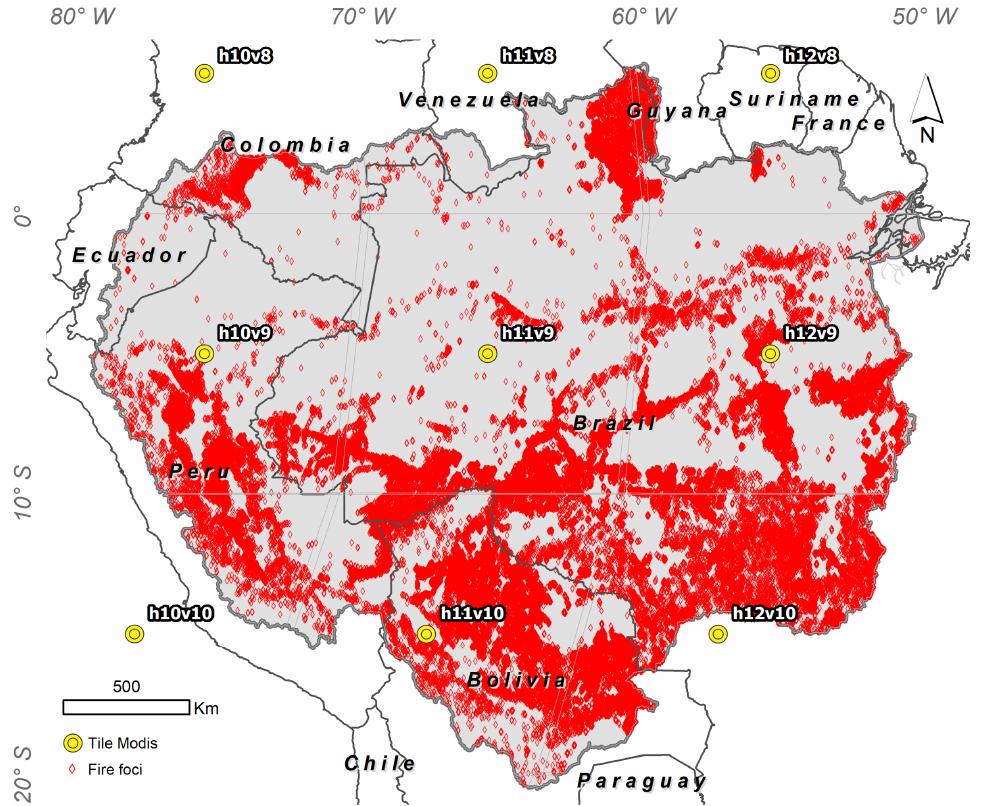
Figure 1. Study area located in the Amazon Basin (South America) with fire foci from January to August 2019 obtained from Moderate Resolution Imaging Spectroradiometer (MODIS) data. MODIS tile centers are marked by a red circle with the corresponding reference code (Terra/Aqua [50]).